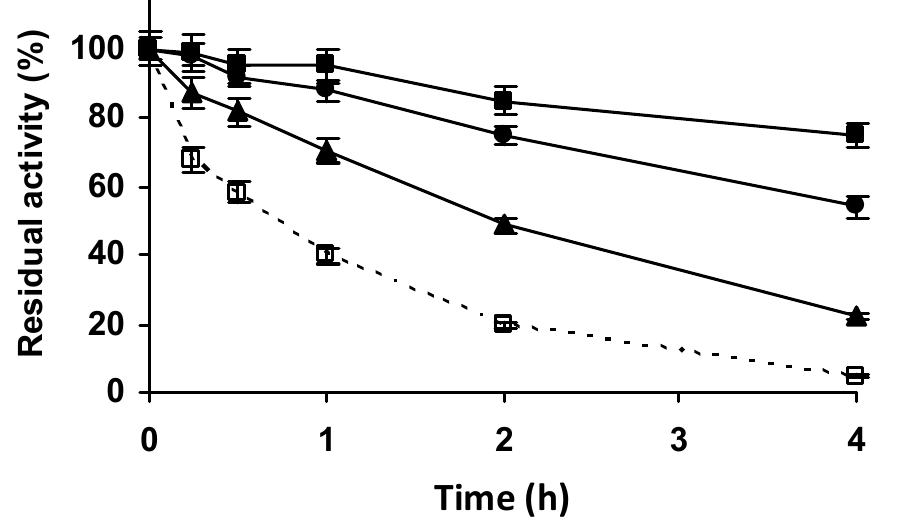
Figure 4. Inactivation courses of r Aae UPO at pH 10.0 under different conditions. The experiments were performed in 50 mM sodium carbonate. Other specifications can be found in the Methods section. Empty squares with dotted line: no additive at 25 °C; full triangles: 20 % glycerol at 25 °C; full circles: 40% glycerol at 25 °C; full squares: 40% glycerol at 4 °C.